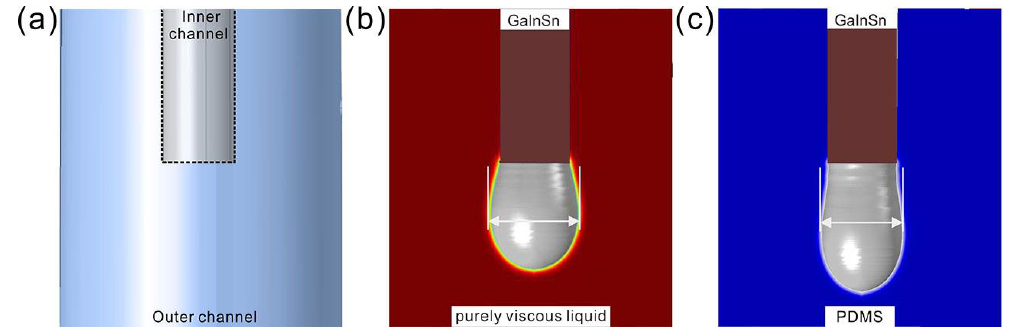
Figure 3. Simulated behavior of liquid alloy in the coaxial nozzle. ( a ) The model of flow field; ( b ) simulated behavior of liquid alloy with a purely viscous outer flow with the same viscosity as the PDMS; ( c ) simulated behavior of liquid alloy with PDMS squeezing. The flow rates of GaInSn and outer channel flow are 16 μL/min and 80 μL/min, respectively. The diameters of the inner channel and outer channel are 210 μm and 800 μm,